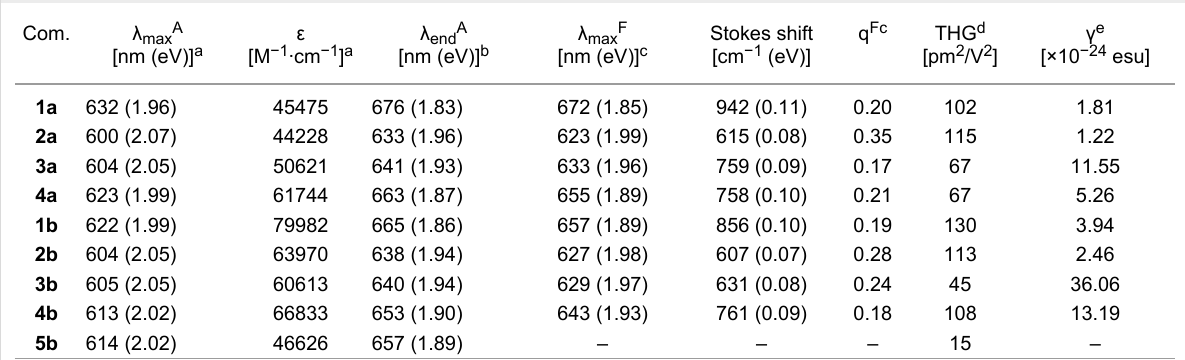
Table 2: Optical properties of chromophores 1 – 5 . Com.